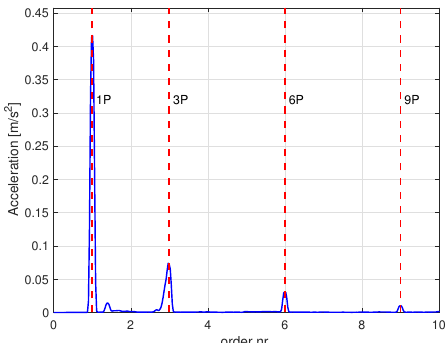
Figure 14. Order spectrum for Y direction tower vibrations from the FAST model: rotor